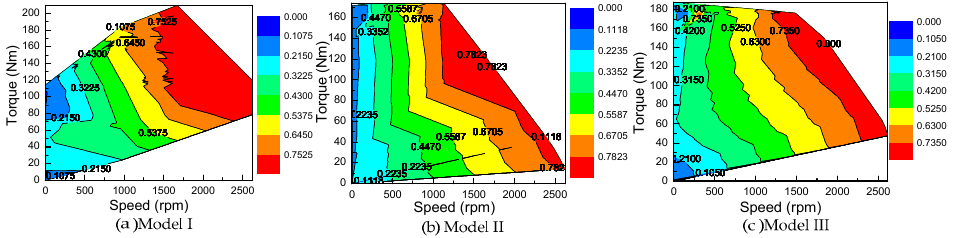
Figure 17. The DC bus voltage utilization rate when torque the command is limited at 190 Nm.